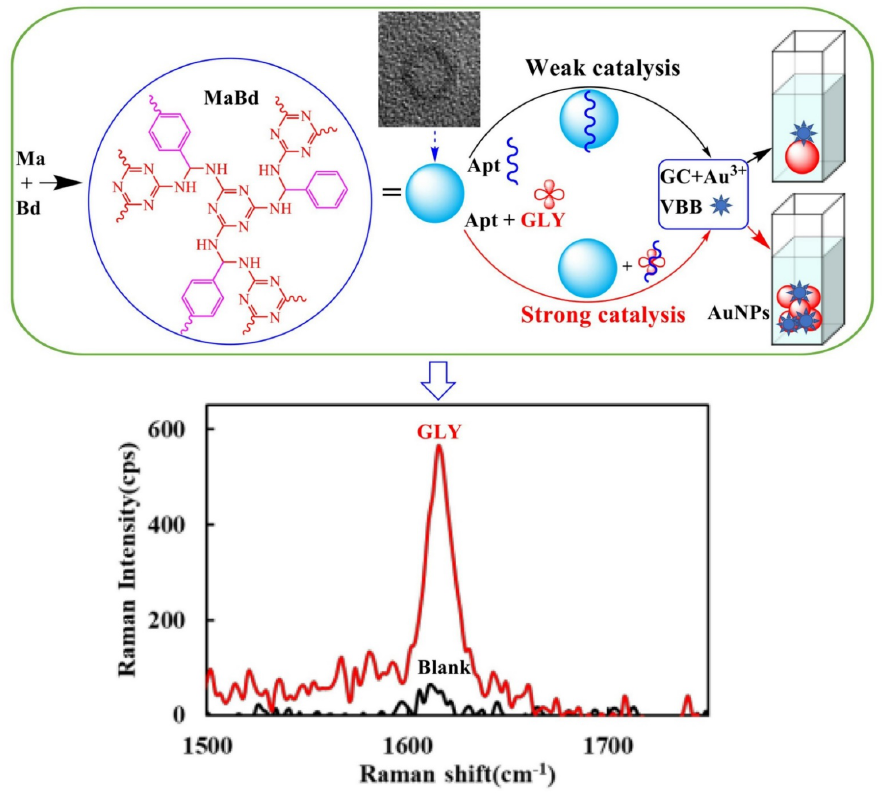
Figure 21. Aptamer regulated-MaBd catalysis of GC-HAuCl 4 nanogold reaction to detect GLYP with two scattering techniques. Reprinted with permission from [185]. Copyright 2021 Elsevier.